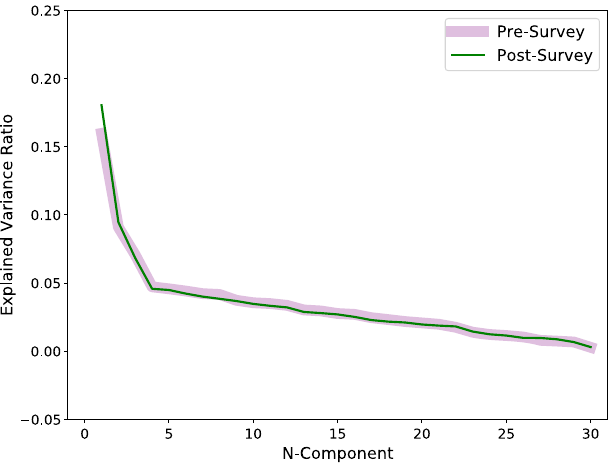
FIG. 7. The explained variance ratio of the question items (also known as a “ scree ” plot [82]) for both the pre- and postsurveys. The explained variance ratio is the fraction of variance explained per component as opposed to the raw variance given per component. If the E-CLASS measured latent factors, the amount of variance explained prior to the elbow would be much higher. In this plot, we see that the components before the elbow account for about 30% of the variance, and the explained variance does not reach a critical amount ( > 0 . 8 ) before including at least